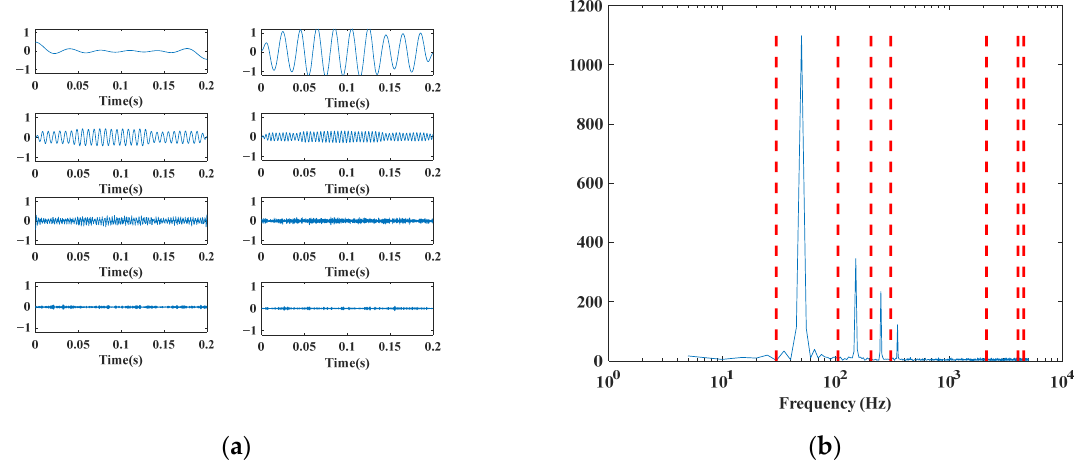
Figure 11. Swell with harmonics decomposition results by EWT when K = 8. ( a ) Results in the time domain; ( b ) Results in the frequency domain.